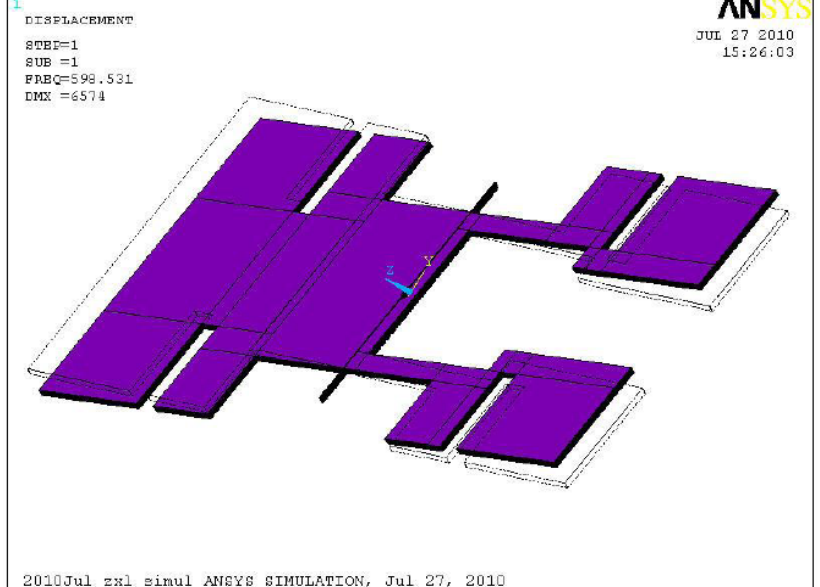
Figure 4. Modal analysis result of 1st order natural